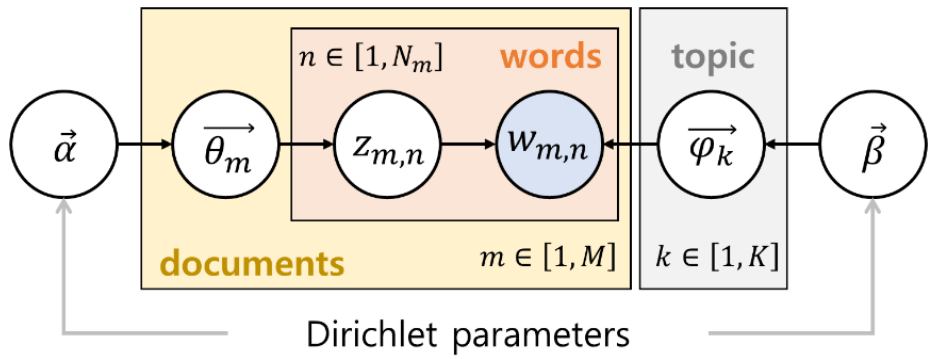
Figure 1. Graphical model of Latent Dirichlet Allocation (LDA).